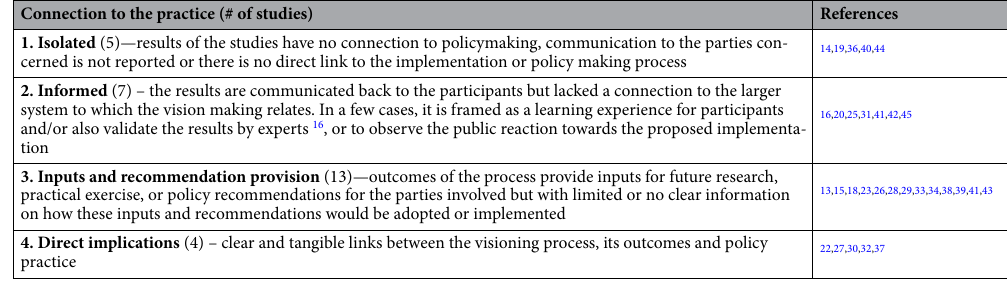
Table 3. Four levels of connection to the